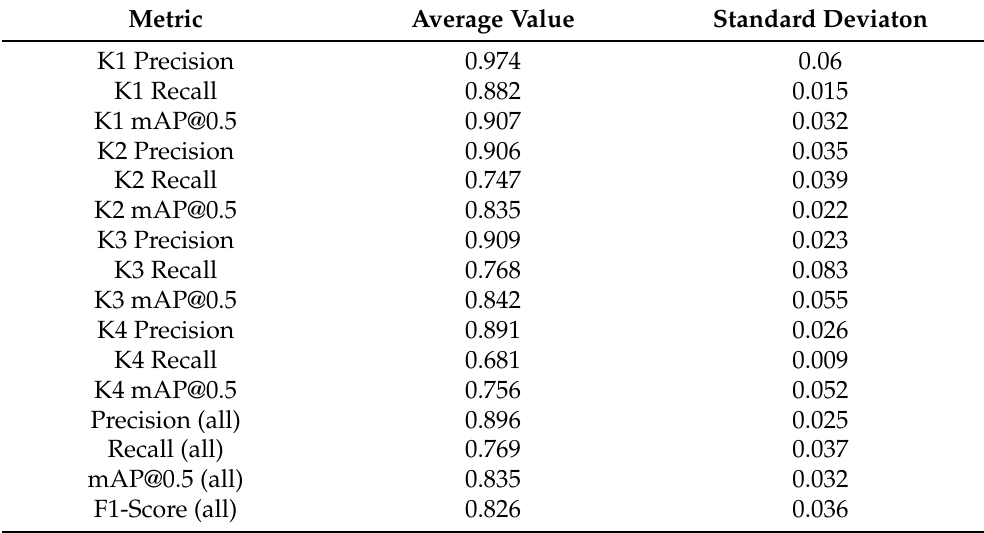
Table 10. Base model + augmentation pipeline evaluation